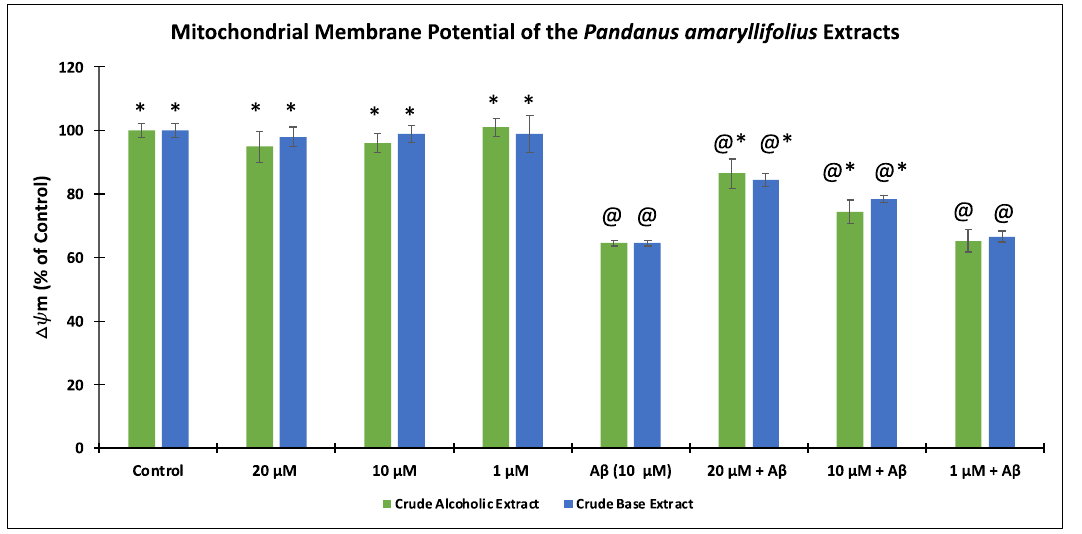
Figure 5. Assessment of the mitochondrial membrane potential ( ∆Ψ m) of Pandanus amaryllifolius extracts using the tetramethylrhodamine methyl ester (TMRE) assay. SH-SY5Y cells were pre-treated with the extracts for 6 h, followed by A β (10 μ M) for 24 h. The ∆Ψ m (% of the control cells) was expressed as the mean ± SD of triplicate measurements. @- statistically significant ( p < 0.05) vs. control; *- statistically significant ( p < 0.05) vs. A β -treated cells.